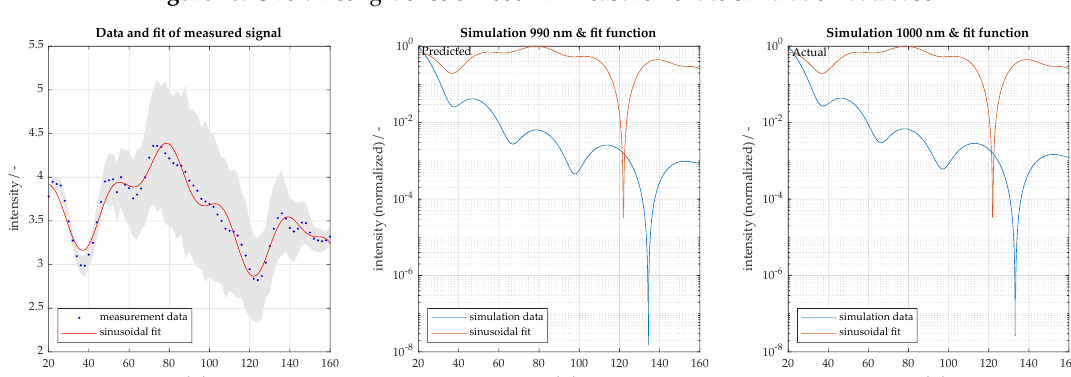
Figure 10. Overall congruence of 1000 nm measurement to simulation database.